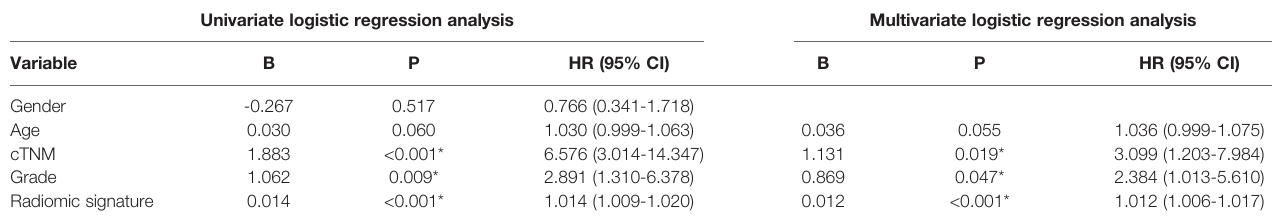
TABLE 3 | Univariate and multivariate Cox regression analysis of radiomic